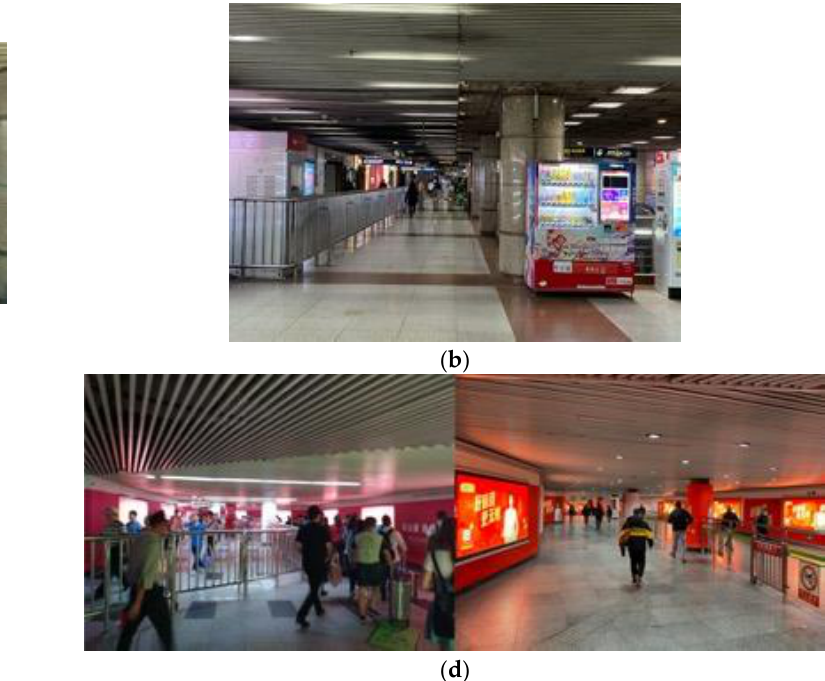
Figure 15. Current situation of the transfer space environment comfort of sample stations: ( a ) Poor wind and sound environment; ( b ) aged equipment; ( c ) low sanitation and cleanliness; ( d ) severe light pollution. Images courtesy of the author.